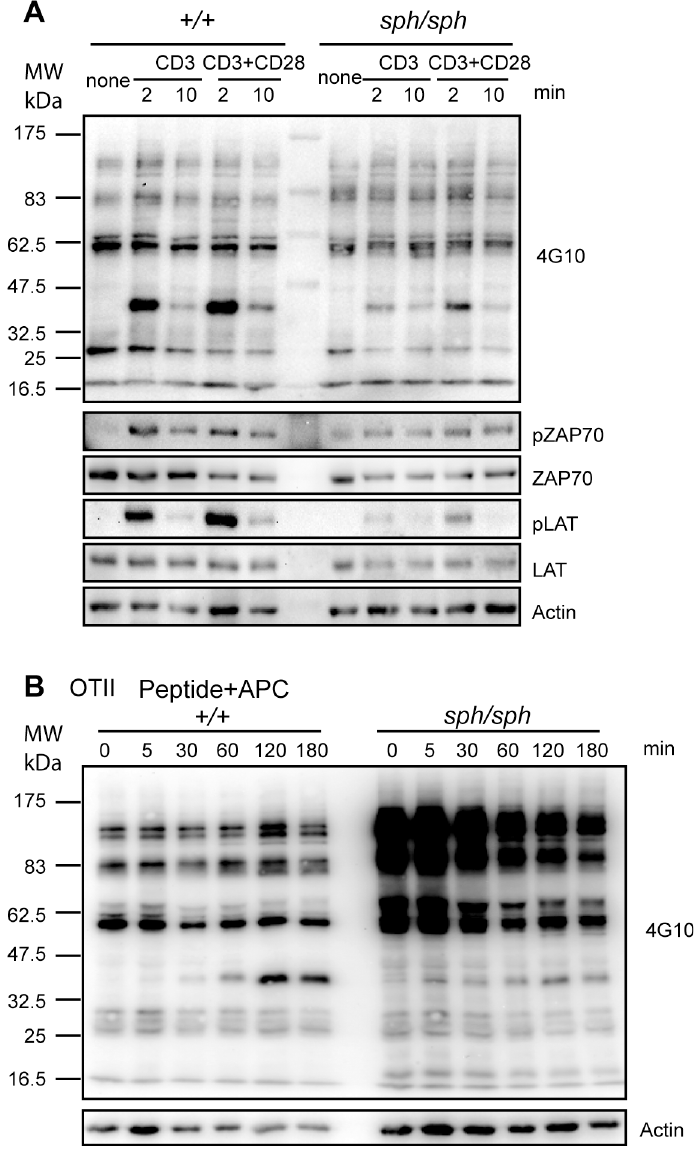
Fig 3. TCR-induced proximal signaling is decreased in Gimap5 deficient T cells. (A) Purified CD4 + T cells from control and Gimap5 sph/sph mice were left un-stimulated or stimulated with 5 μ g/ μ L anti-CD3 or anti- CD3&CD28 antibodies for the indicated duration. Lysates were subjected to Western blot analysis. Representative data from one of 3 independent experiments are shown. (B) CD4 + T cells from OT-II TCR- transgenic control and from Gimap5 sph/sph mice were co-cultured with irradiated APC pulsed with OVA peptide at a ratio of APC: CD4 + T cells (8:1) for different durations of time. Cell lysates were prepared and phosphorylation of the tyrosine recidue was detected using 4G10 antibody. Representative data from one of 3 independent experiments are